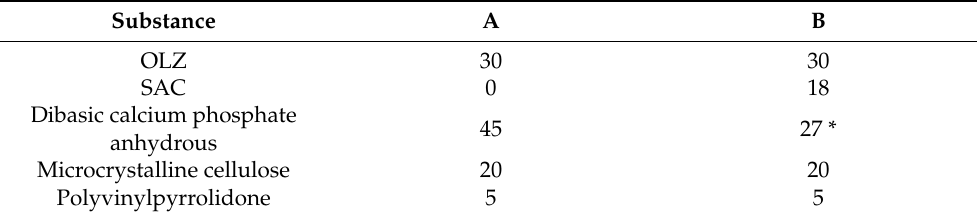
Table 1. Composition (%) of formulations A and B used for